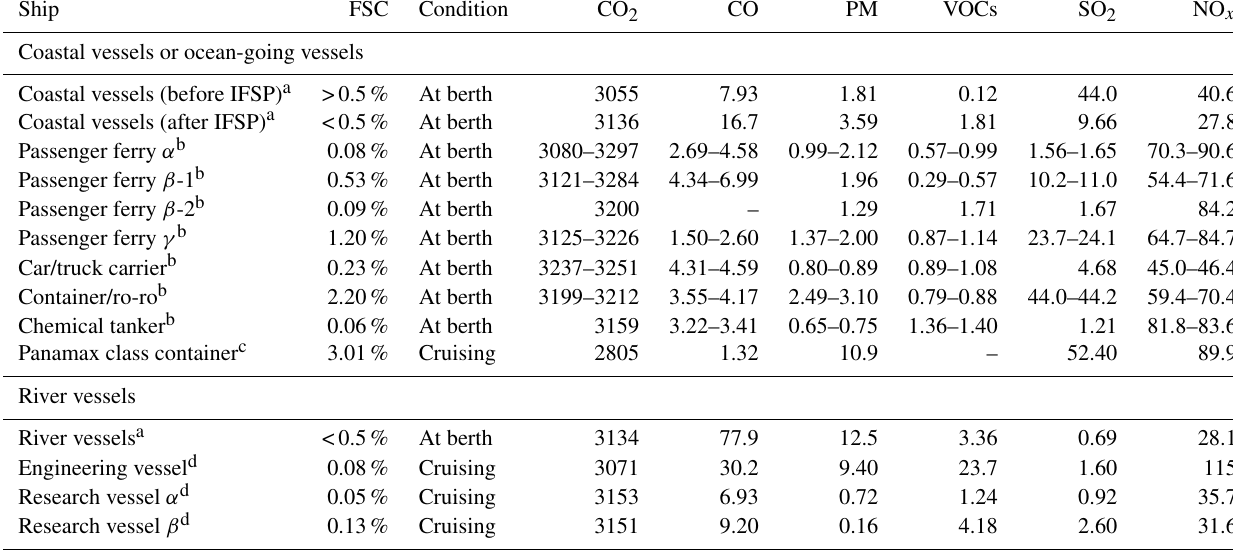
Table 3. Fuel-based average EFs (gkg − 1 ) from this study in comparison with those reported previously. Ship